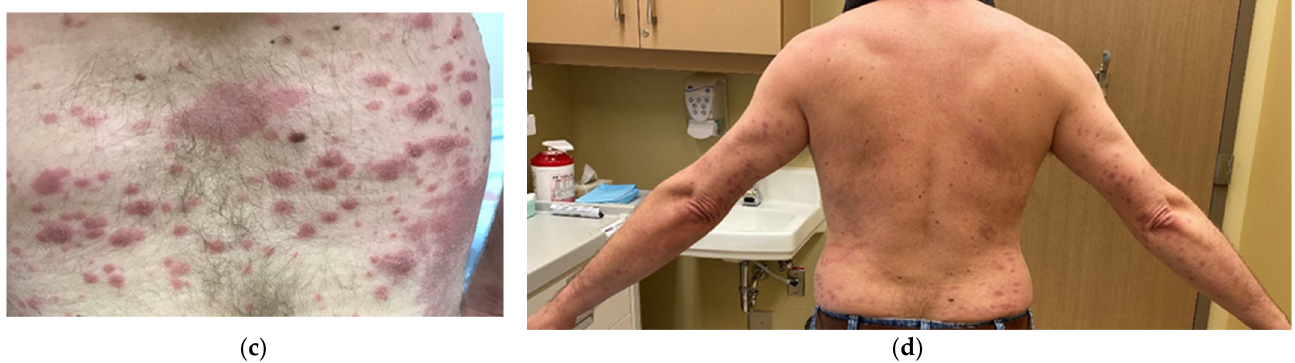
Figure 1. Skin lesions: at diagnosis ( a ) right arm, ( b ) thighs, ( c ) lower back, and post treatment ( d ) arms and back.